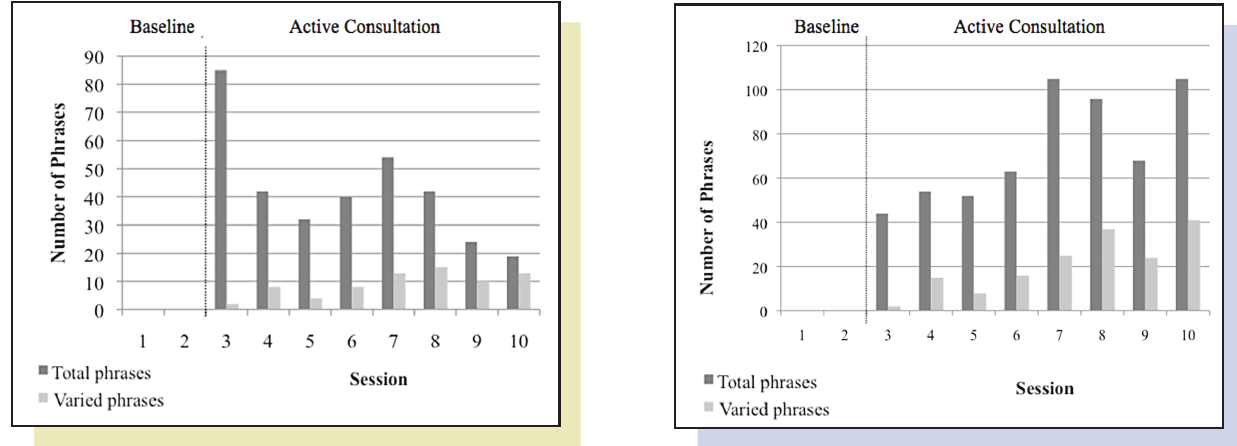
Table 4. Clinician & Client Baseline and Active Consultation Data (frequency count)